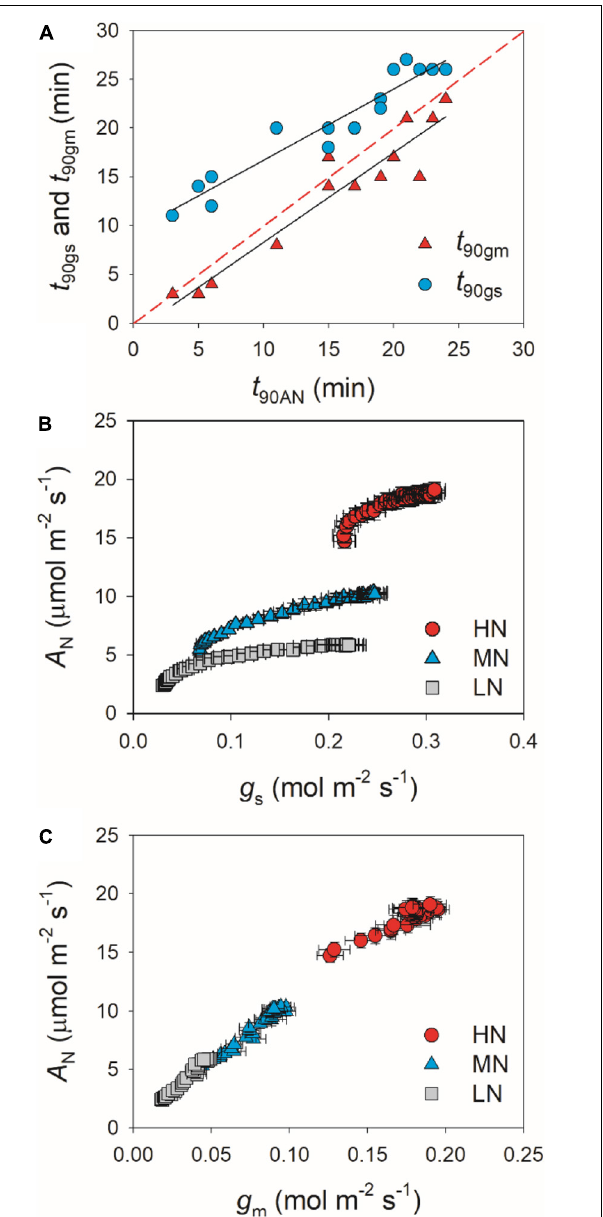
FIGURE 3 | (A) Relationships between t 90 AN , t 90 gs , and t 90 gm after transition from 50 to 1,500 µ mol photons m − 2 s − 1 . (B,C) Relationships between g s , g m , and A N after transition from 50 to 1,500 µ mol photons m − 2 s − 1 . Values are means ± SE ( n = 5). HN, MN, and LN represent tomato plants grown under high, medium, and low N concentrations,